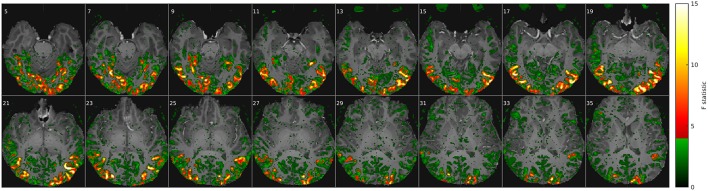
Movie stimuli elicited a widely distributed fMRI response throughout the brain. Example of a voxel-wise ANOVA F-statistic map (threshold p < 1%, uncorrected) superimposed on the T1-weighted anatomical MRI of one representative subject (16 axial slices in radiological convention). Stimulus-correlated fMRI activity is widespread in the occipital and ventral temporal cortices, consistent with their established involvement in basic vision and object recognition. Red/yellow colors mark the top 214 voxel features that maximized classification rates in Figure 2.